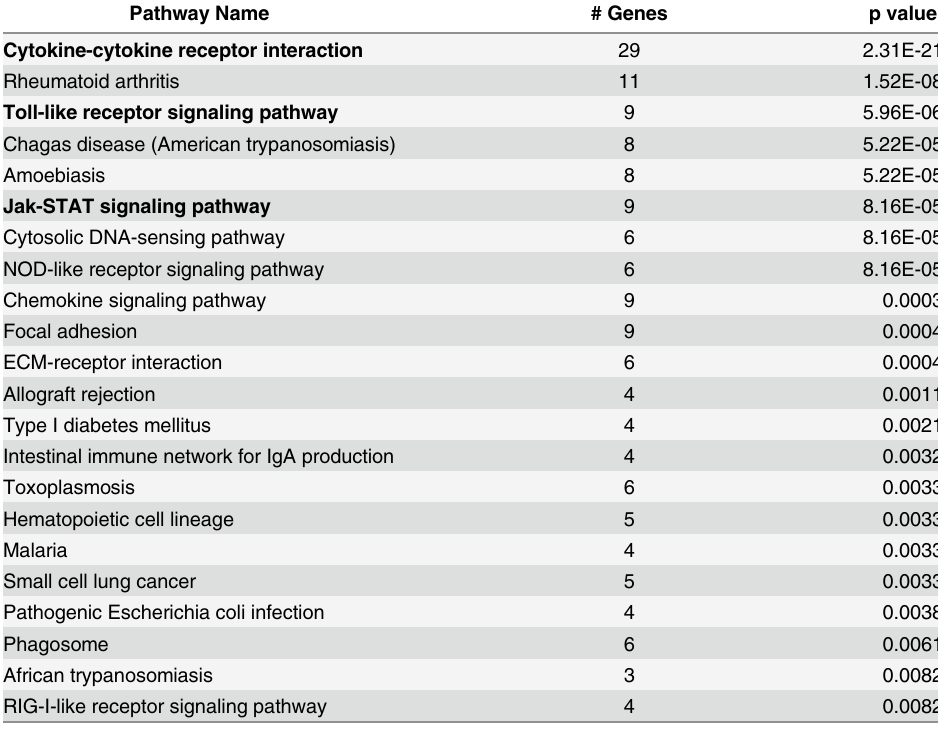
Table 2. Significantly enriched pathways for genes regulated similarly to IL12B by